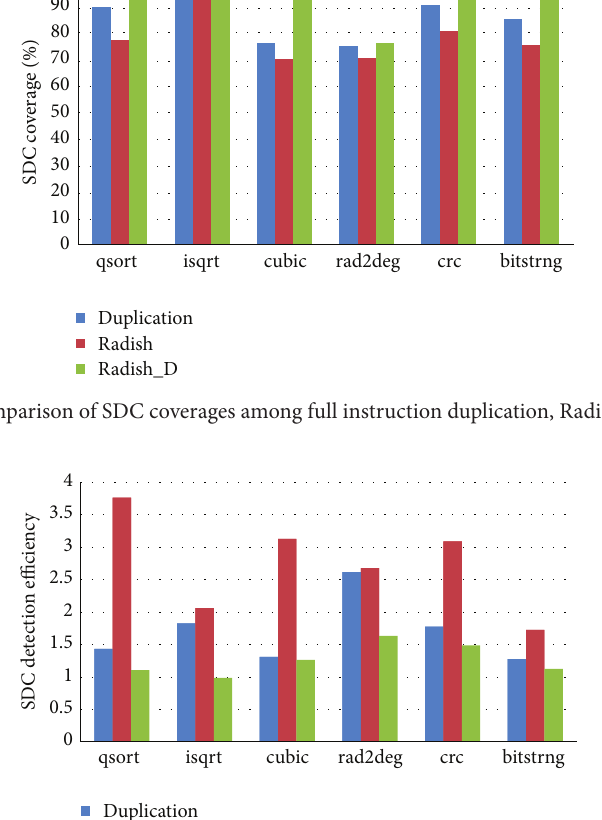
We also conduct the experiment to exam the effect of training set size. The result of qsort is shown in Figure 7. The training set consists of 25, 50, and 75 inputs and false positives are computed across 100